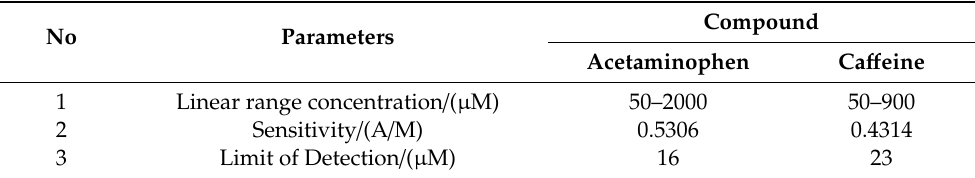
Figure 10. DPV voltammogram sample P ( a ), sample B ( b ) and sample O, ( c ) Each sample was dissolved in PB pH 2, measured both by GCE-M221-Fe 3 O 4 and unmodified GCE as the working electrode.